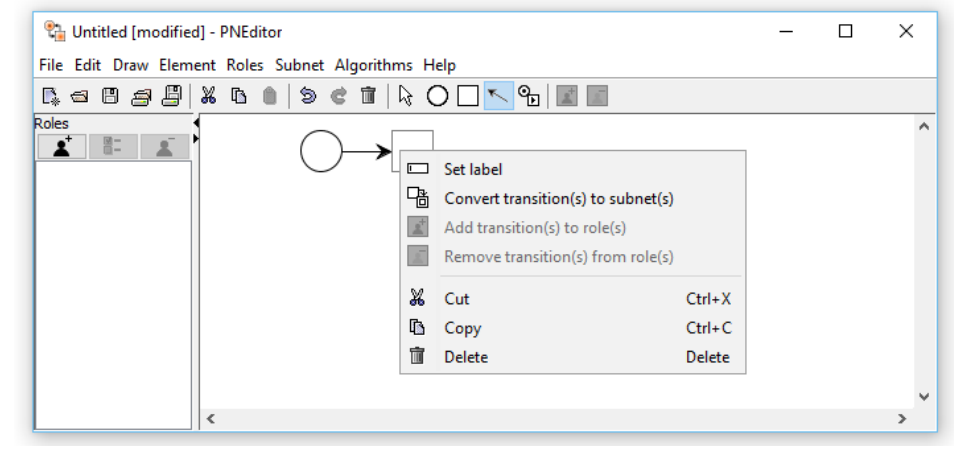
Figure 5. GUI of original